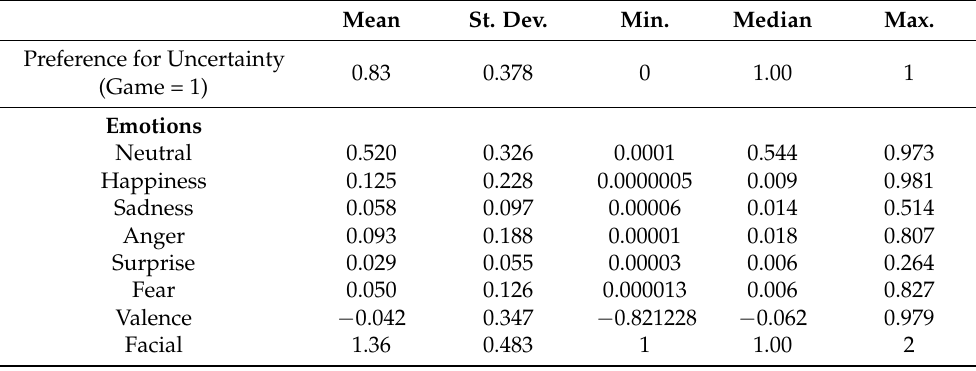
Table 4. Descriptive Statistic about Emotions.